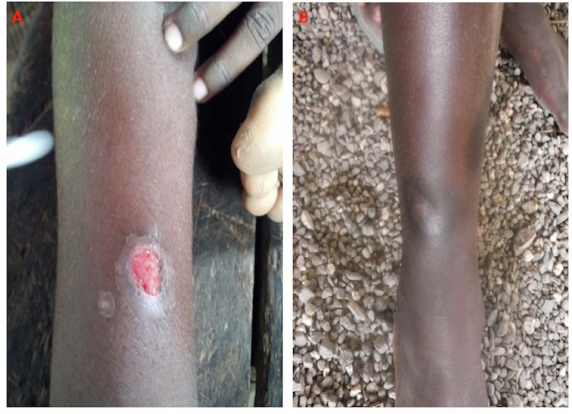
Figure 1. Clinical lesions of yaws. a) Primary yaws ulcer. b) Healed yaws lesion. Images credit: Michael